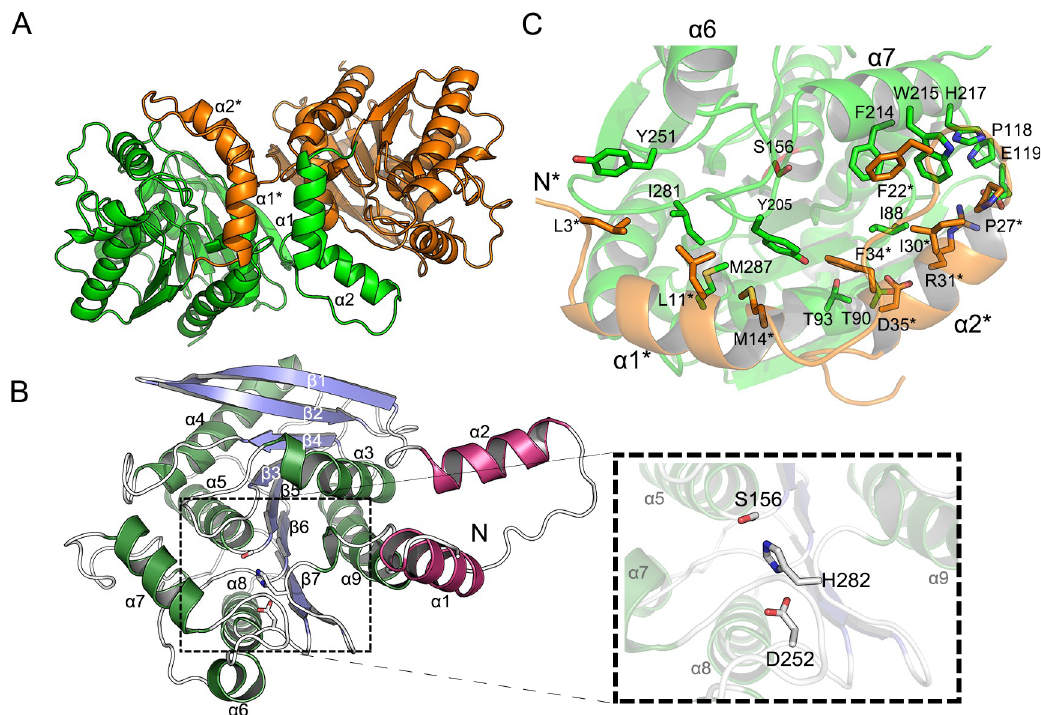
Fig 2. Dimeric and monomeric structures of EstDL136( Δ PMP). (A) The two monomers in the asymmetric unit of the apo- form EstDL136( Δ PMP) are shown in different colors. Note that the CAP domain of one monomer intercalates into the core α / β fold of the adjacent monomer. (B) The monomeric structure of the apo-form EstDL136( Δ PMP) is shown, with an enlarged view of the catalytic triad Asp252-His282-Ser156. Blue corresponds to the central β -sheet, green to α -helices, and magenta to the CAP region. (C) Intersubunit-interacting residues within 5 Å are indicated for those in the CAP domain and an α / β fold of adjacent monomer. Note that the catalytic residue Ser156 is shown for the location of the active